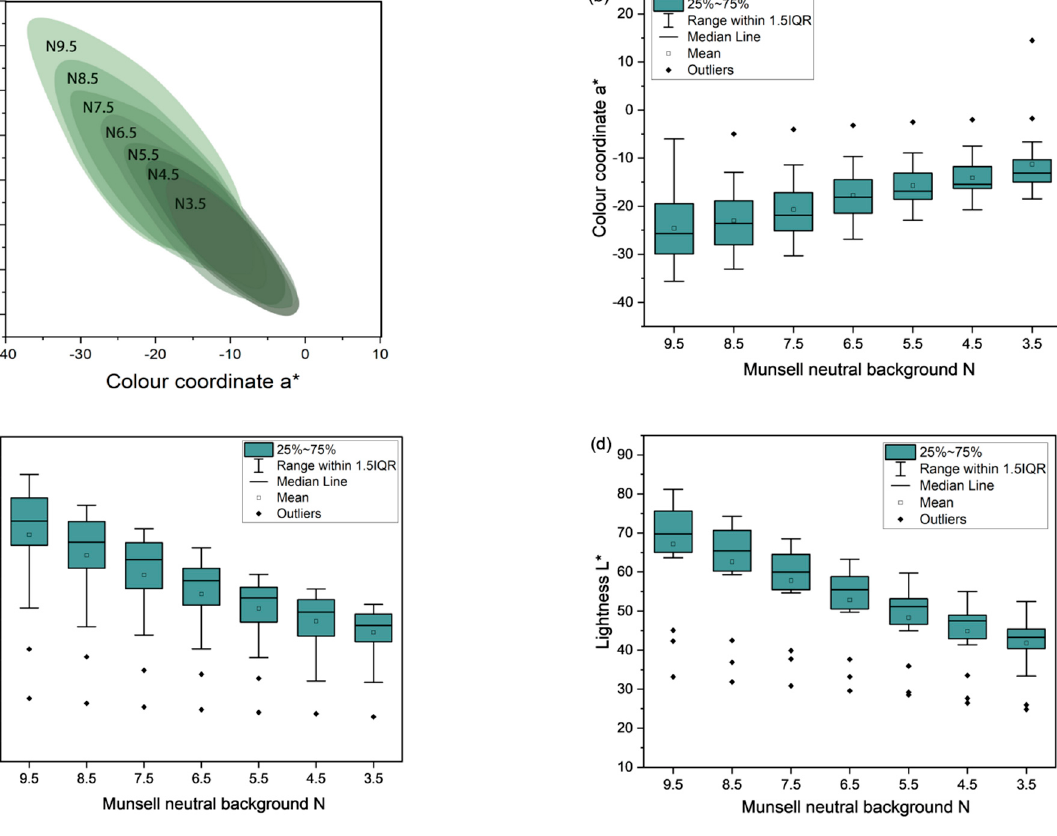
Figure 4. ( a ) Distribution of a* and b* values of 20 samples using different Munsell backgrounds; ( b – d ) changes of a*, b* and L* using different backgrounds. Each box is the a* (b*, L*) value of all samples using that background.